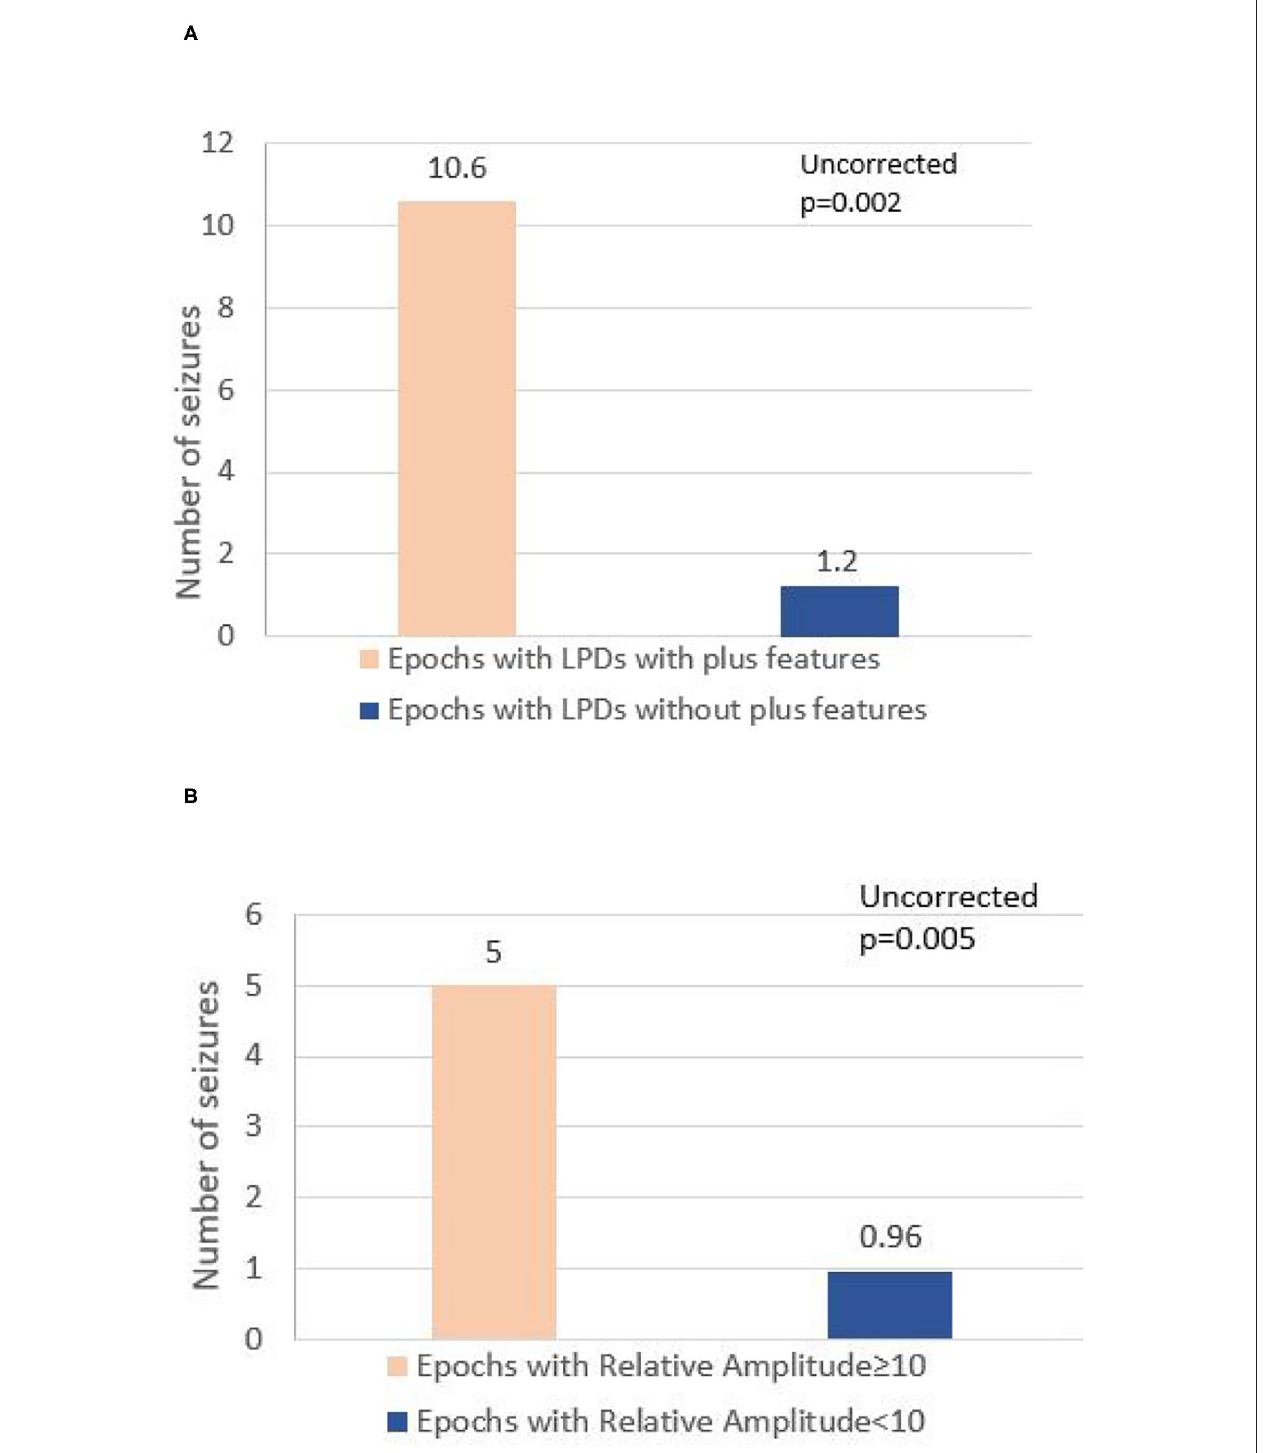
FIGURE 2 | (A) Comparison of number of seizures between epochs with LPDs with plus features and epochs with LPDs without plus features in all 20 patients. (B) Comparison of number of seizures between epochs with LPD relative amplitude ≥ 10 and epochs with LPD of relative amplitude < 10 in all 20 patients.